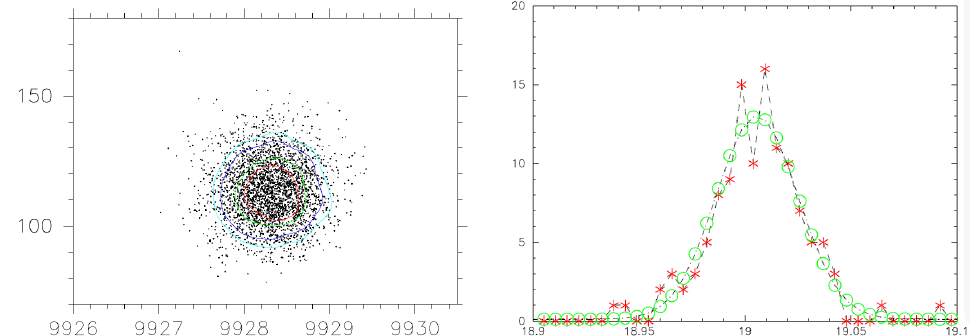
Figure 2. An example of the posteriori distribution of a weak line at mass 19. The background around the line is very low. The weak line has an observed maximum of 16 counts. The top panel shows the posteriori distributions in total count vs. time flight bin. The red curve contains 50% posteriori confidence limits, the green curve 68%, the dark blue 90%, and the light blue 95% limits. Note that the most likely value has a rather symmetric distribution with a 68% confidence width of about 0.34 TOF time bins or 0.002 u in mass, and an integrated mean count of 113 ± 11 counts. The mass 19.0056 u is within 0.0077 u or F + 18.9979 u . The line does not agree quite as well with heavy water HDO + of mass 19.0162 u or the hydrogenated water ion (hydronium) H 3 O + with a mass of 19.0178 u . These are off by 0.0106 and 0.0122 u , respectively, from the calculated line position. The expected hydronium line would have a time-of-flight bin of 9929.53, which is not in agreement with the posteriori distribution of the upper panel. The spectrum used here is from flight model